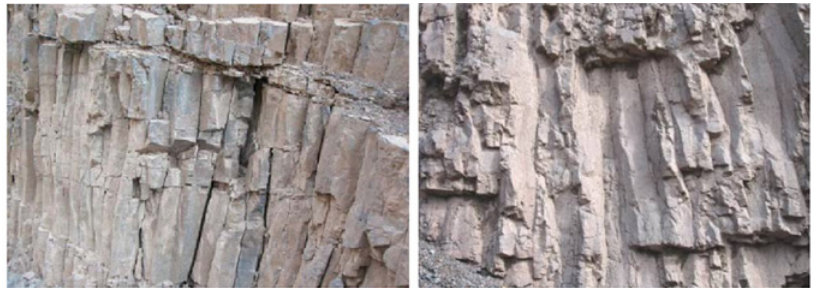
Fig 1. The joint net work of